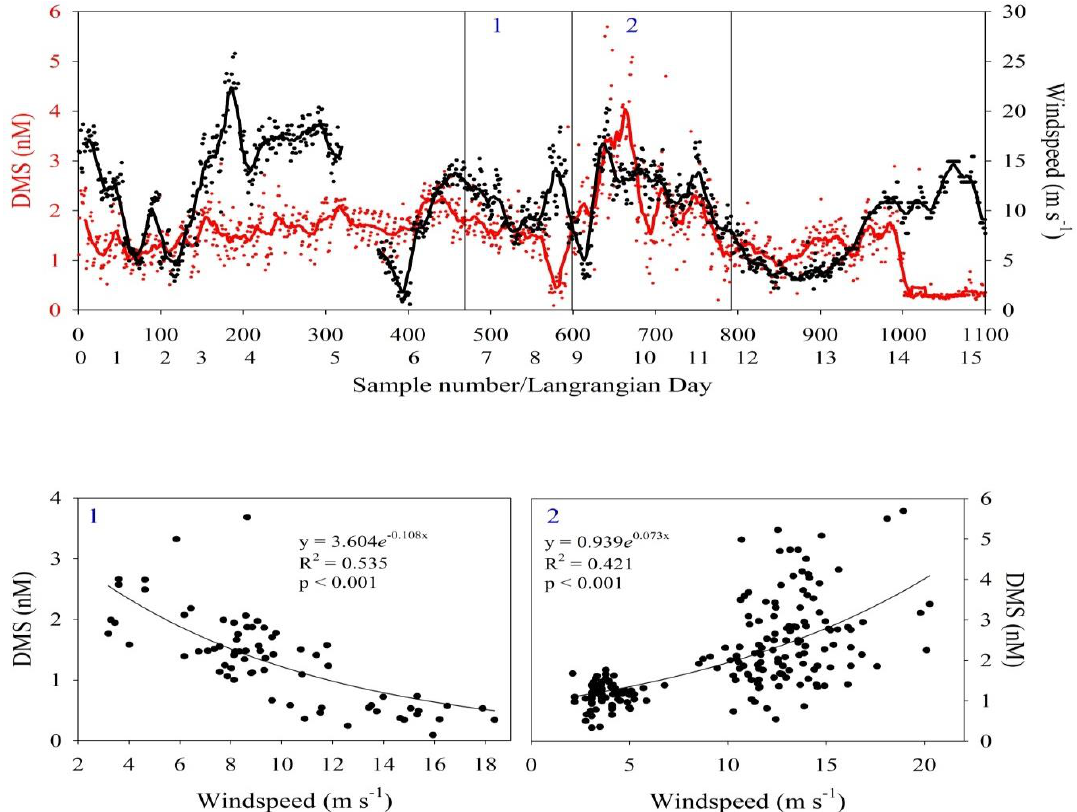
Figure 5. Surface seawater underway DMS (nM) concentrations with concurrent wind speed (m/s) measurements (upper graph, red = DMS, black = wind speed) and correlations between DMS and wind speed (lower graph, period 1 = no iron enrichment, period 2 = iron enrichment).